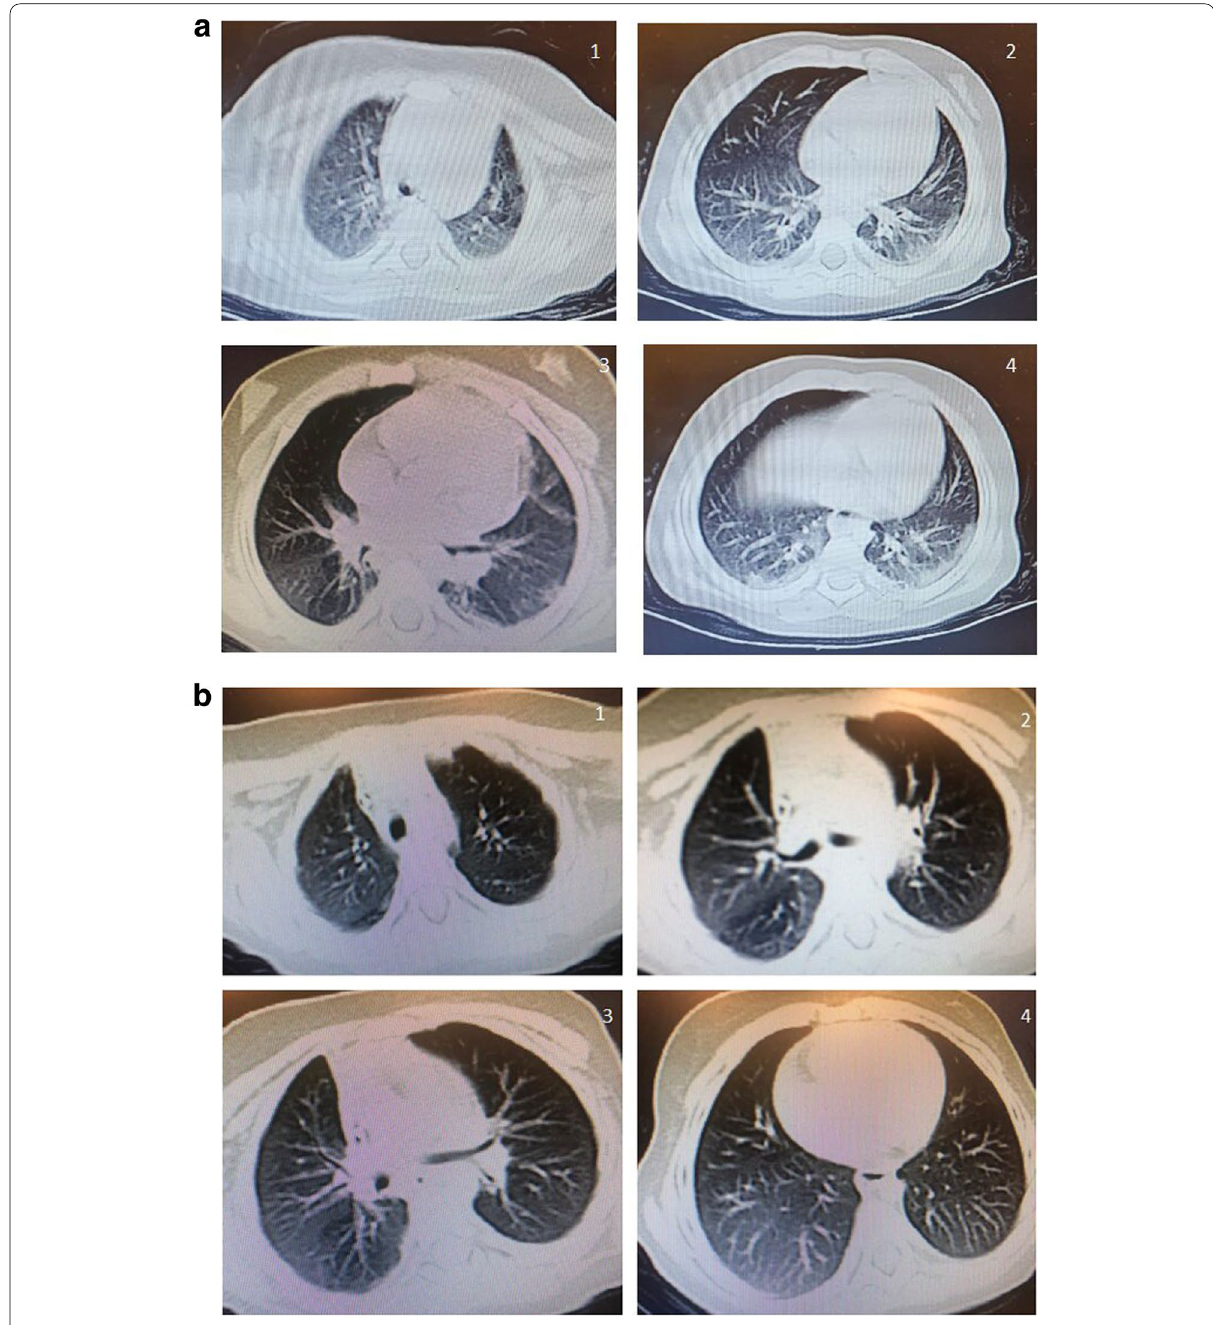
Fig. 2 a Case 2 initial serial CT cuts showing bilateral multiple pulmonary asymmetric variably defined multilobar areas of ground-glass opacities predominantly peripheral with sub-pleural posterior consolidations with related accentuated vascularity and air space pattern involving all both lung lobes (CO-RADS 4). b Follow-up case 1 serial CT cuts showing significant regressive course with marked resolution, but still noted ground glass veiling and bronchial thickening denoting post inflammatory small airway disease